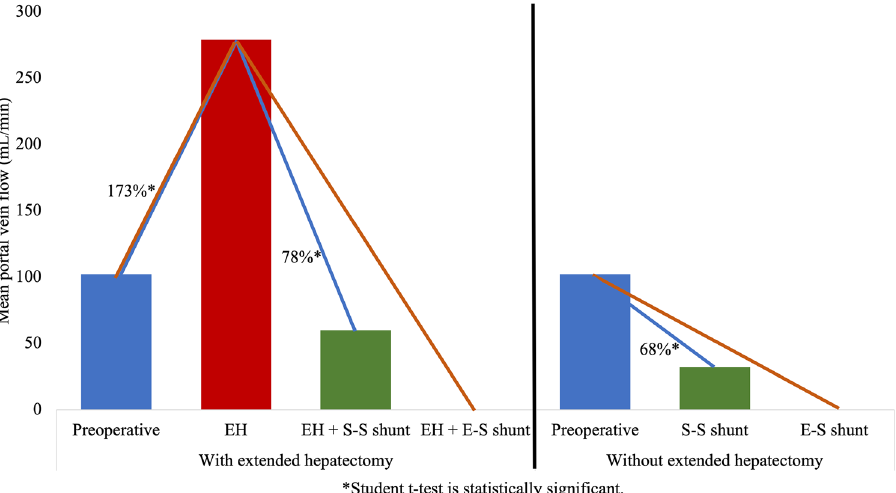
Figure 1. PVF changes with and without EH in three steps without PCS, with a side-to-side portocaval shunt (S–S PCS) and with an end-to-side portocaval shunt (E–S PCS). (1) EH increases the PVF by 173%; (2) S–S PCS reduces the PVF following EH by 78%; (3) S–S PCS reduces the PVF without EH by 68%; (4) S–S PCS following EH corrects the PVF close to the normal value/100 g.